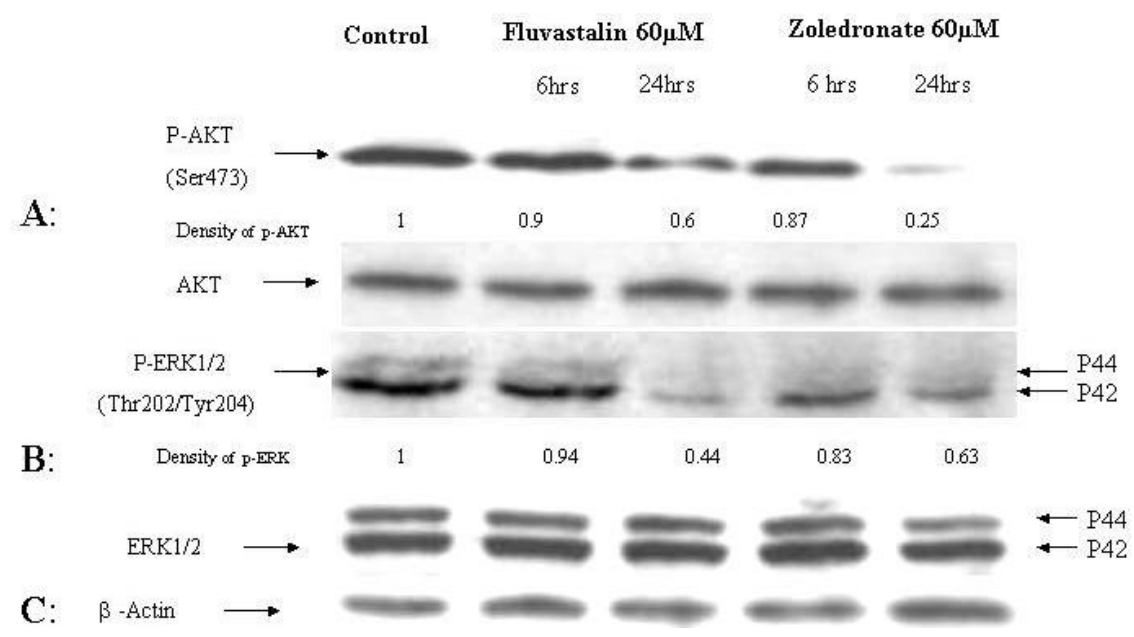
Figure 5. ERK1/2 and AKT pathway inhibition following treatment with fluvastatin and zoledronic acid, with or without rescue by GGPP and FPP. Western blotting results show that GGPP partially restores both phosphorylation of AKT and ERK1/2, while FPP restores phosphorylation of ERK1/2 and has less effect on